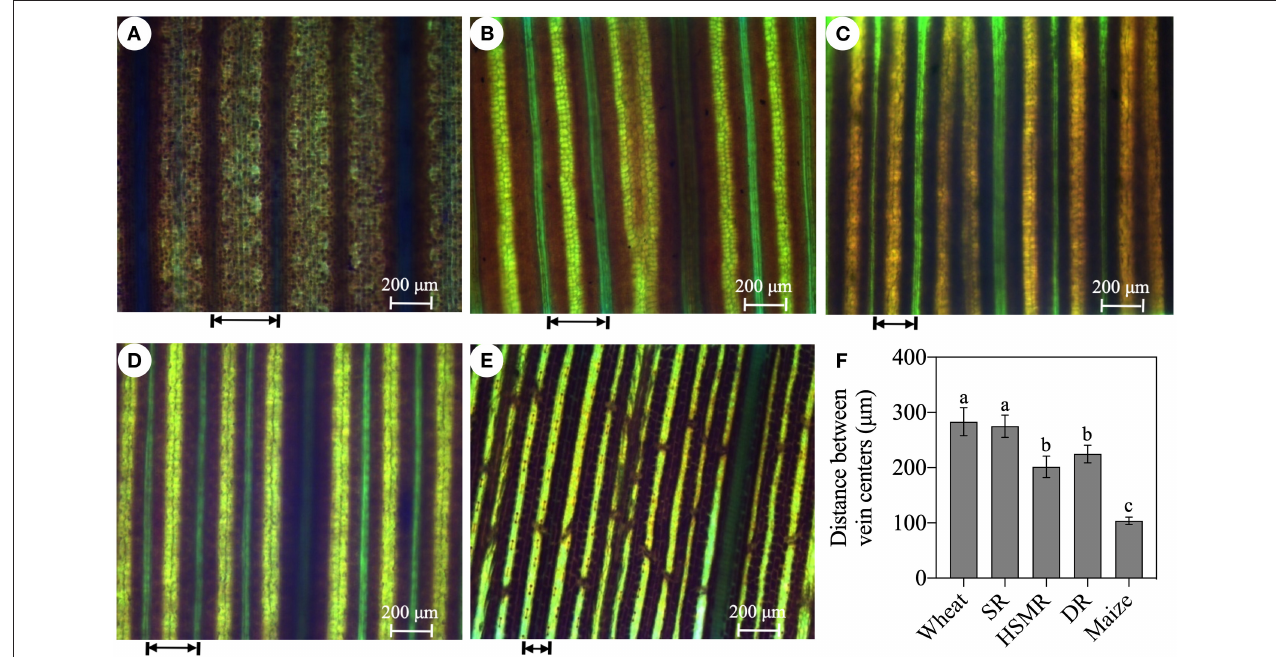
FIGURE 2 | Leaf vein frequencies of the three reed ecotypes and the typical C 3 wheat, the C 4 maize. (A) Typical C 3 wheat; (B) SR, swamp reed; (C) HSMR, heavy salt meadow reed; (D) DR, dune reed; and (E) typical C 4 maize; and (F) the average distance between vein centers of five measured plants. The arrow represents the distance between the veins. Different lowercase letters at the data indicate significant differences among three different ecotypes of reed at p < 0.05 (one-way ANOVA).